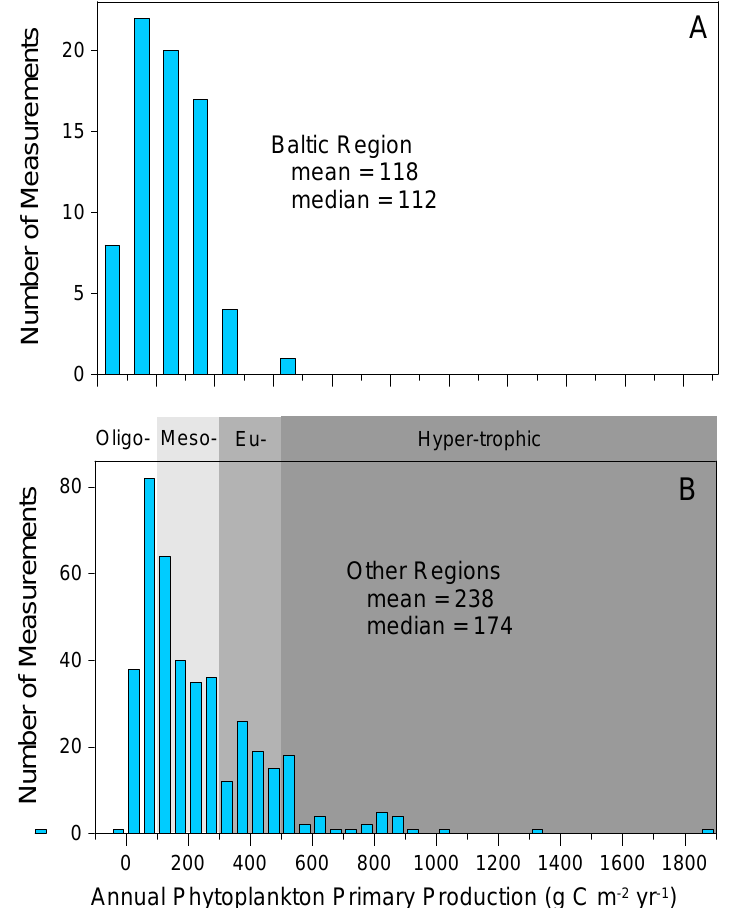
Fig. 3. Frequency distributions of median APPP measured ( A ) at 74 sites in the Baltic region, and ( B ) at 409 sites in other regions. Shaded regions ( B ) partition measurements into Nixon’s classification (Nixon, 1995) of 4 trophic states, from oligotrophic (<100gCm − 2 yr − 1 ) to hypertrophic (>500gCm − 2 yr − 1 )